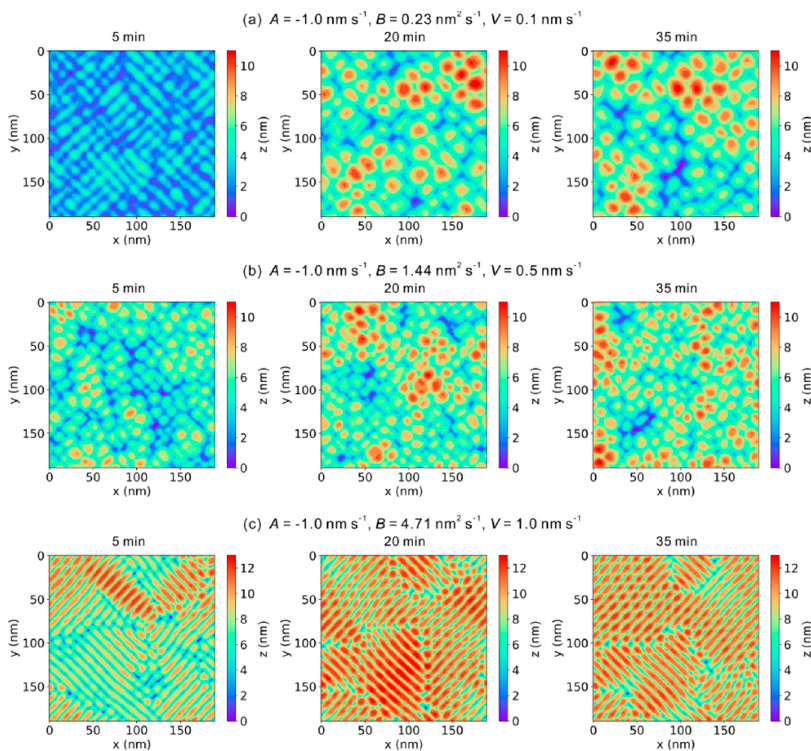
Figure 5. Heat maps of the surface height of thin films deposited with three different deposition rates corresponding to the incident vapor rate fixed as − 0.6 nm s − 1 and three different gas-solid transition velocities at three different deposition time of 5, 20 and 35 min due to the phase-field simulations.